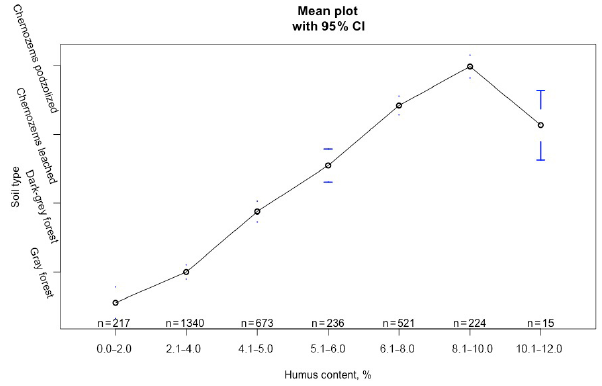
Figure 3. The ANOVA results between the soil type and the humus content.